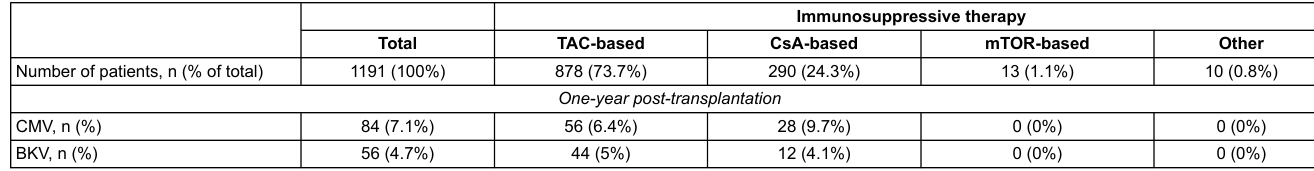
Table 5: Occurrence of CMV and BKV infection at 1 year post transplantation.